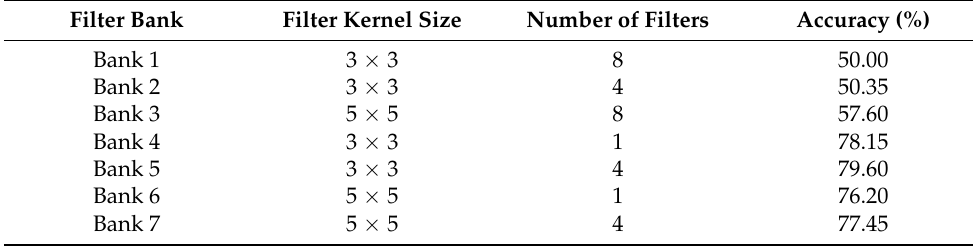
Table 2. Accuracy of filter banks on validation set. Filter